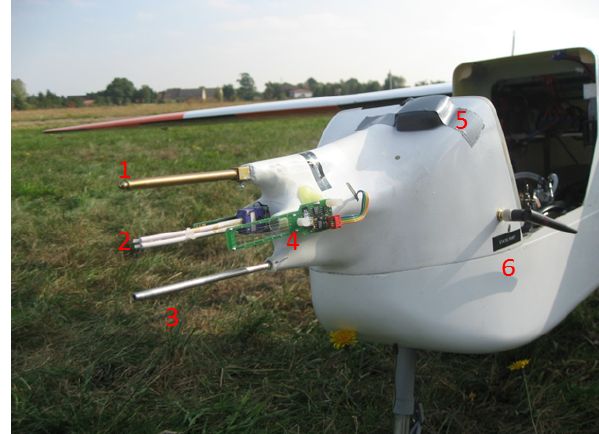
Figure 2. The meteorological payload is mounted at the tip of the aircraft. The components are (1) five-hole probe, (2) temperature sensor (thermocouple) and humidity sensor P14 Rapid, (3) aerosol inlet, (4) fine wire platinum resistance thermometer, (5) GPS an- tenna and (6) telemetry antenna for real-time data transfer. Figure 3. The aerosol payload is installed in the front compartment